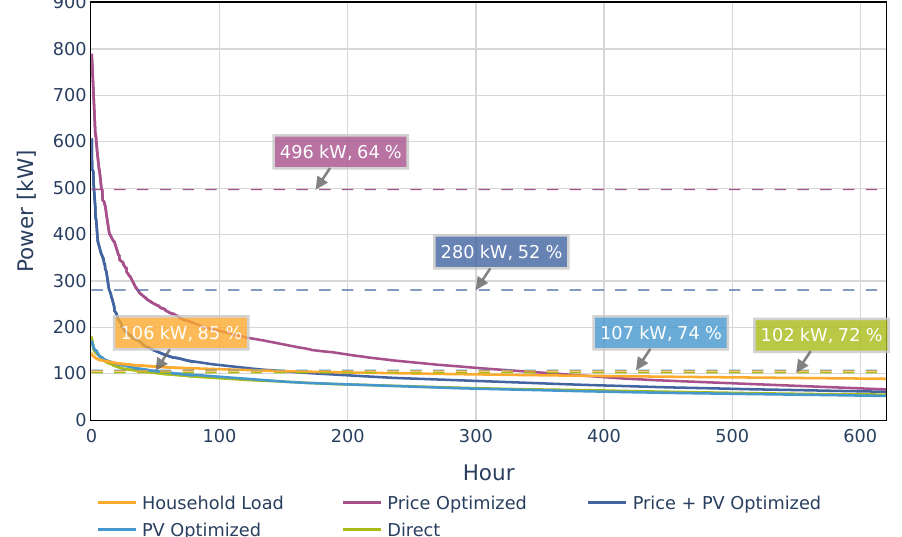
Figure 22. Sorted aggregated charging power for all charging configurations and peak shaving potential after cutting off 3% of energy (dashed